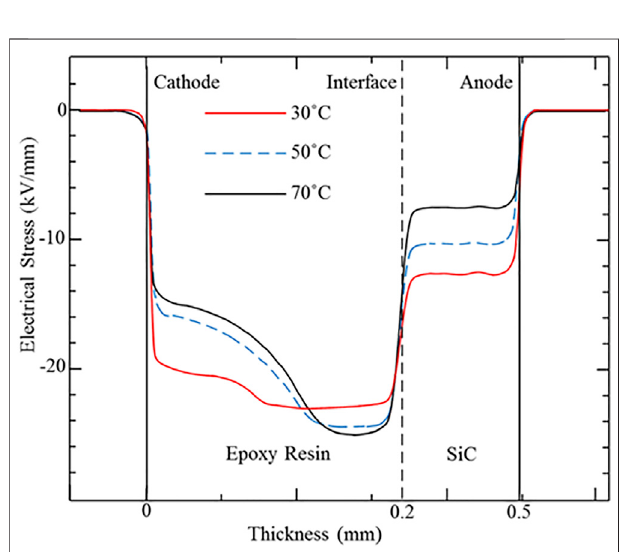
FIGURE 4 | Electrical fi eld distribution for the SiC – epoxy resin double- layered sample under different applied DC electrical stresses.